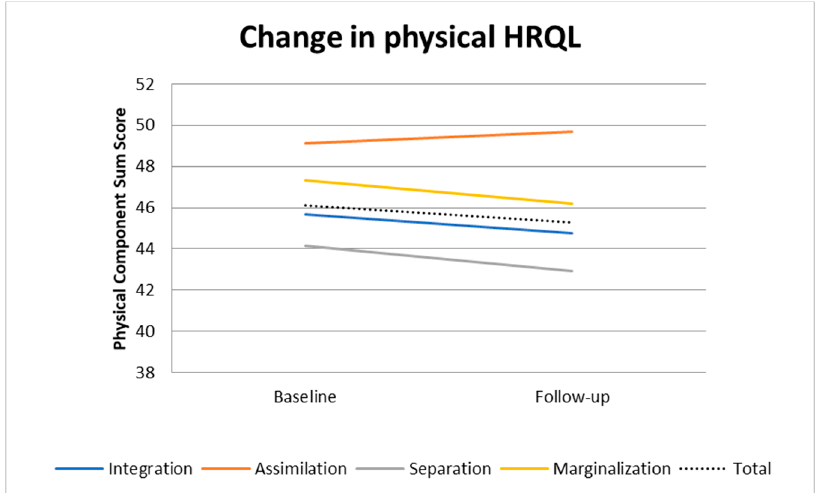
Figure 1. Change over time in physical component summary score (PCS) by acculturation status, adjusted for age, sex, education and income (predictive margins).